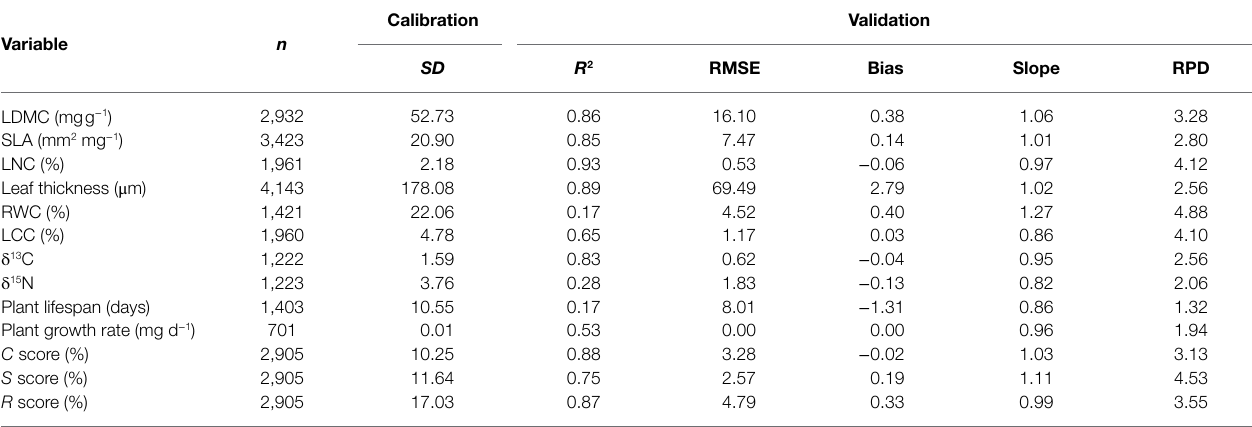
TABLE 1 | Prediction accuracy for functional traits.